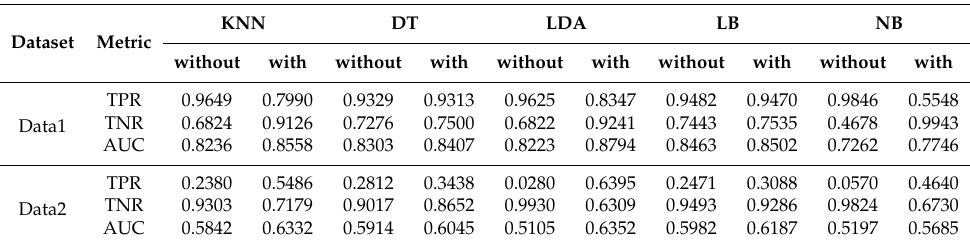
Table 7. Comparison results of classification methods without oversampling and with oversampling in terms of TPR, TNR, and AUC.